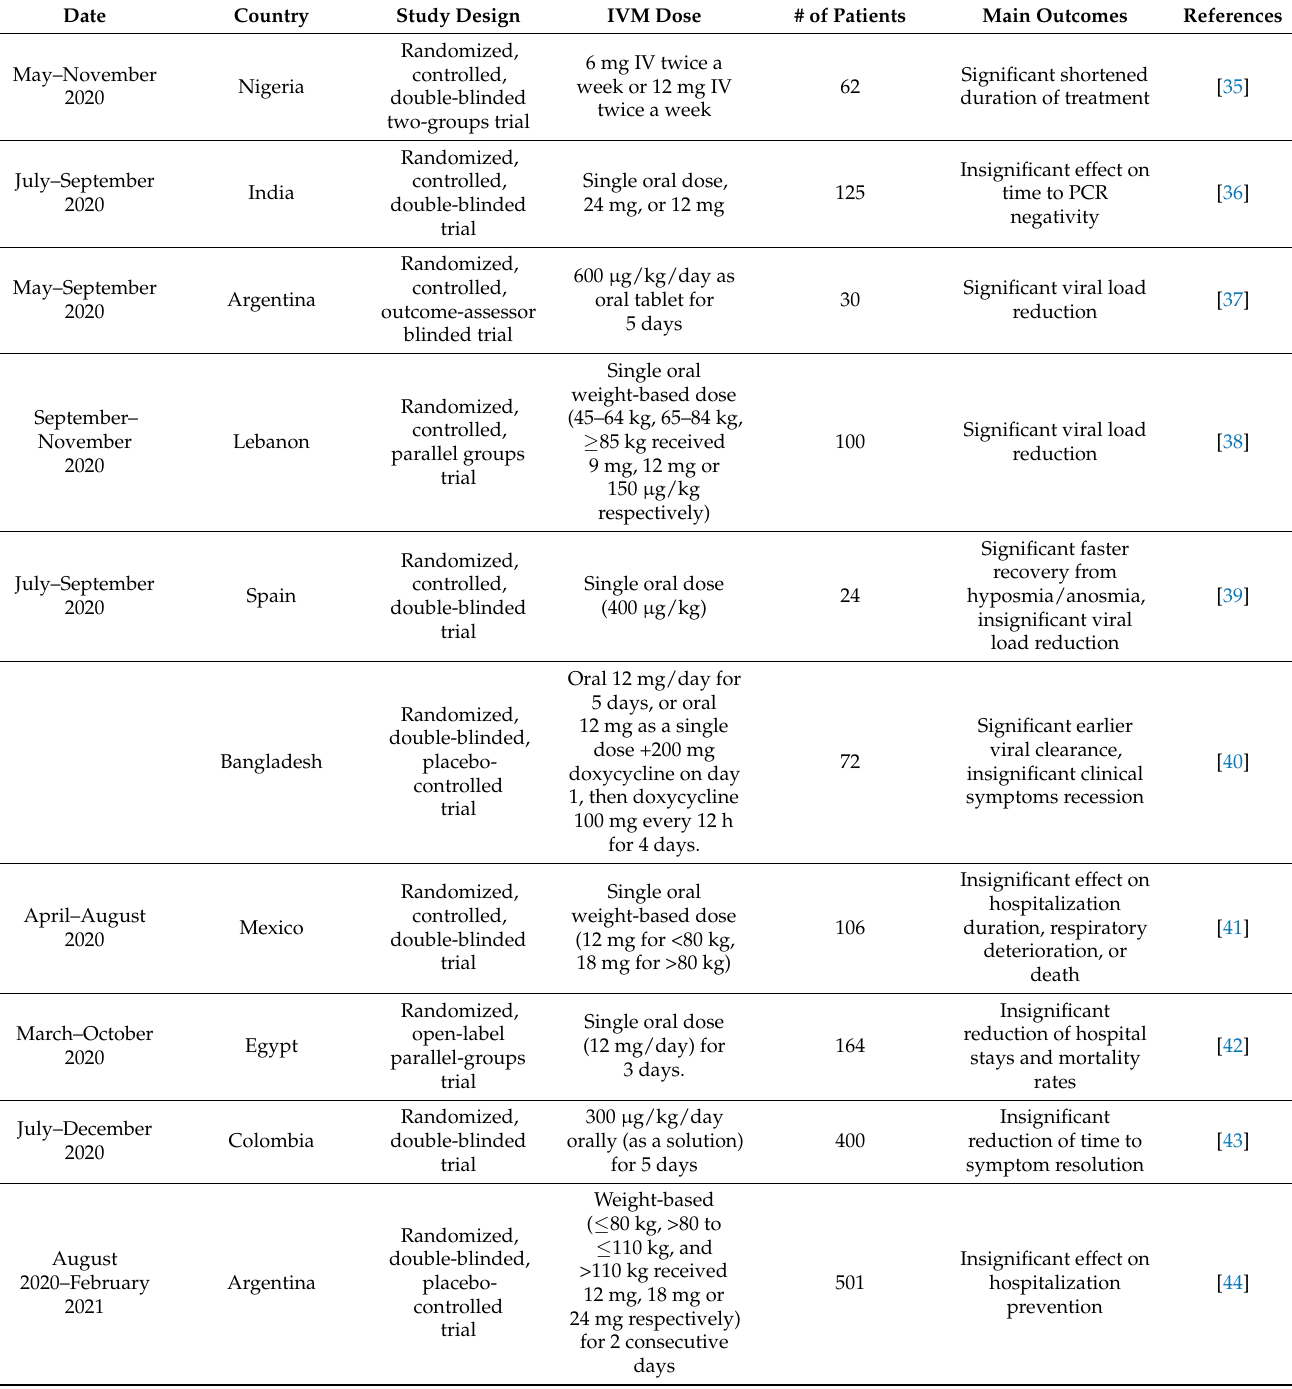
Table 1. Summary of the reviewed studies on the potential of IVM in the treatment of